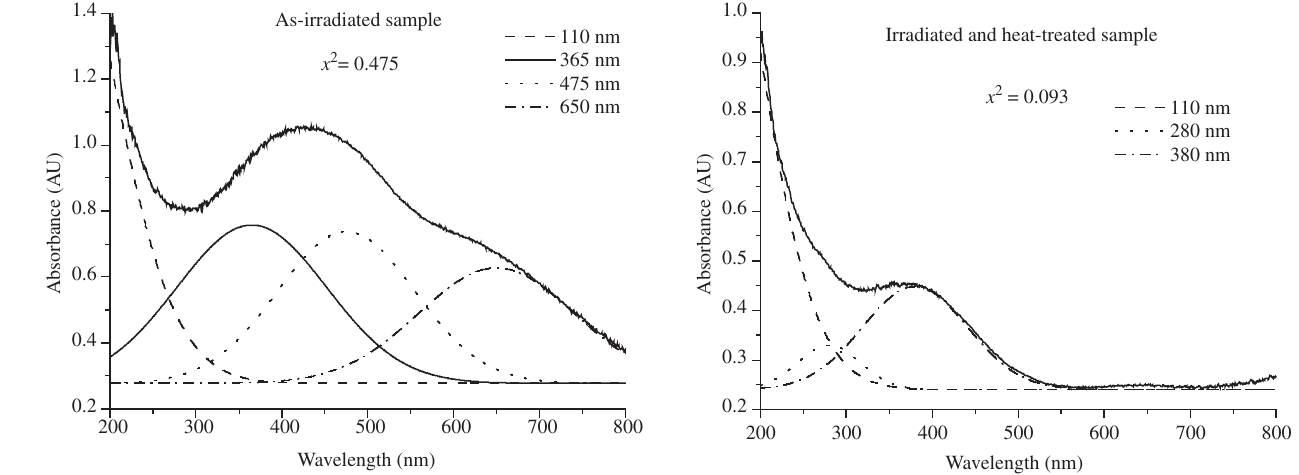
Figure 2. Curve fittings for UV-VIS spectrum of as-irradiated (80 kGy) sample.